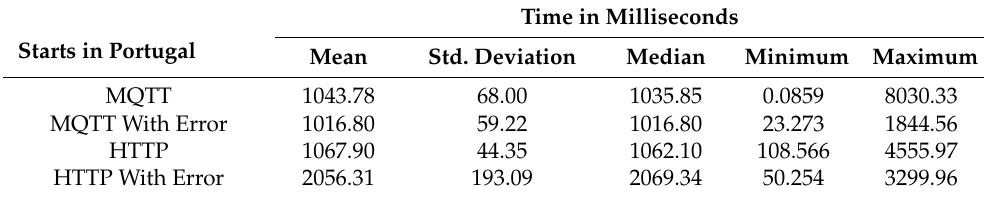
Table 2. Communication that starts and ends in the USA. Starts in the USA